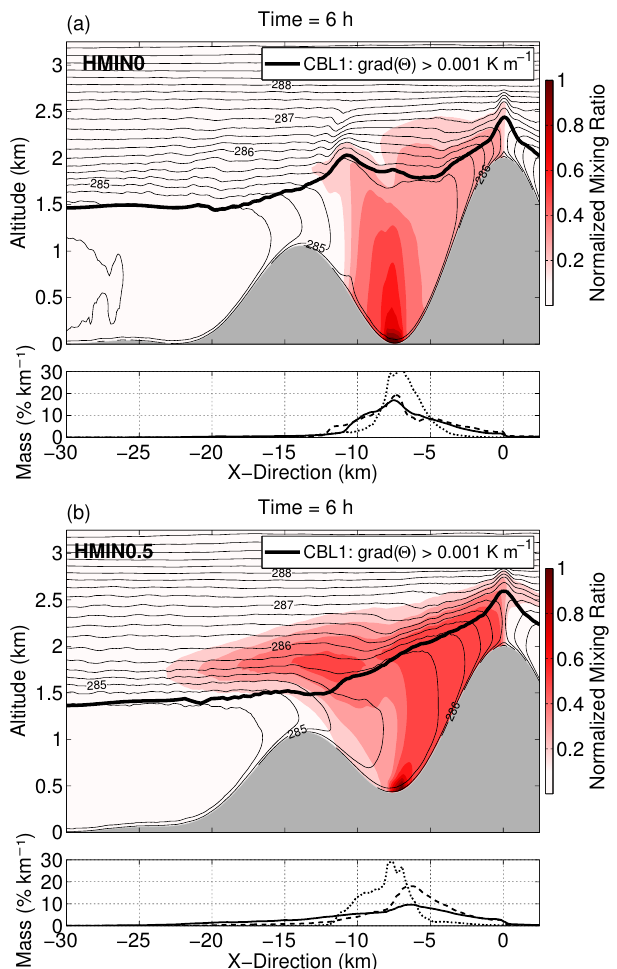
Figure 13. As in Fig. 8 for the (a) HMIN0 and (b) HMIN0.5 sim- ulation, but a tracer has been constantly emitted at the valley floor between − 8 km ≤ x ≤ −